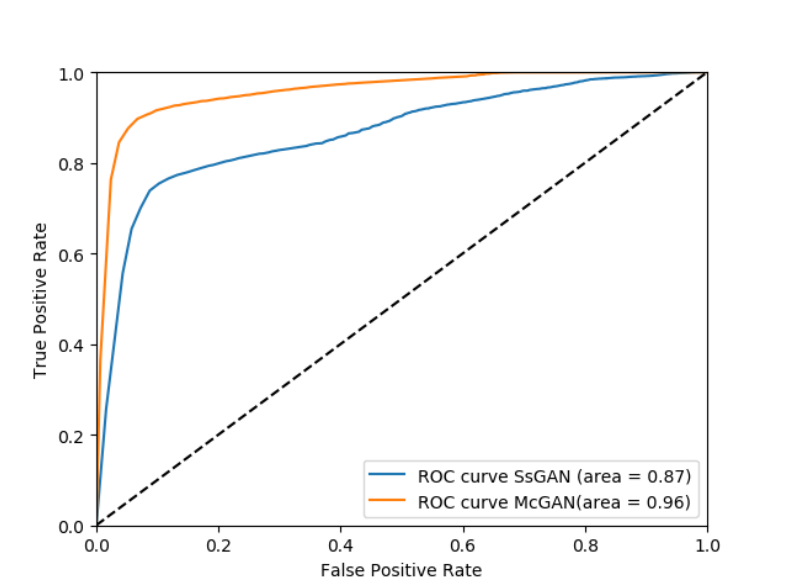
Figure 6. ROC curve of Image 3 in Figure 5.